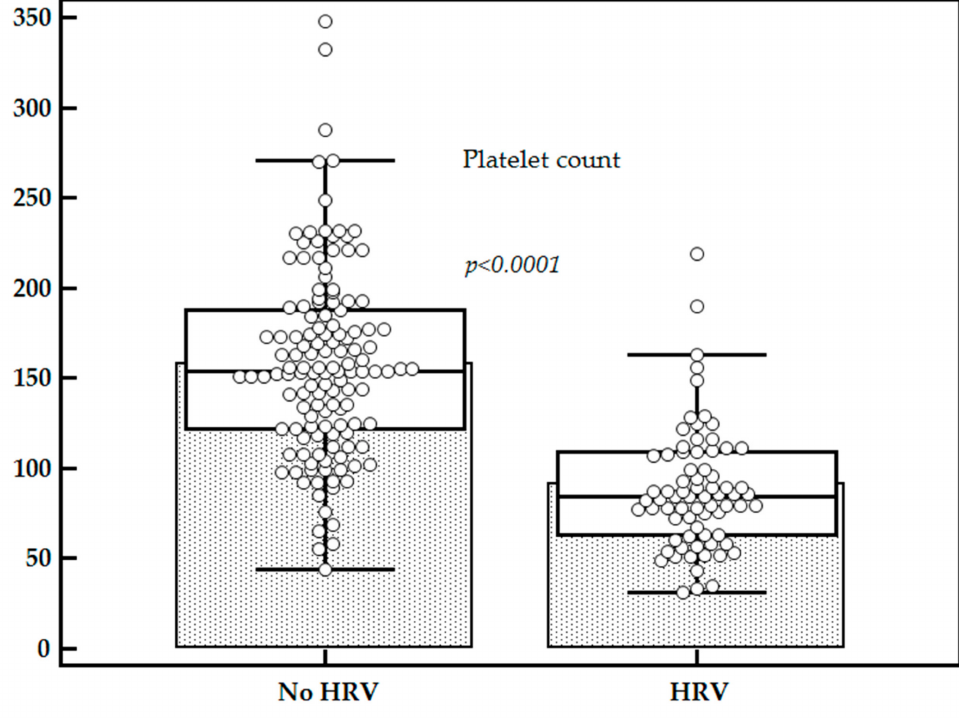
Figure 3. Comparison between platelets count in subjects with HRV vs. subjects without